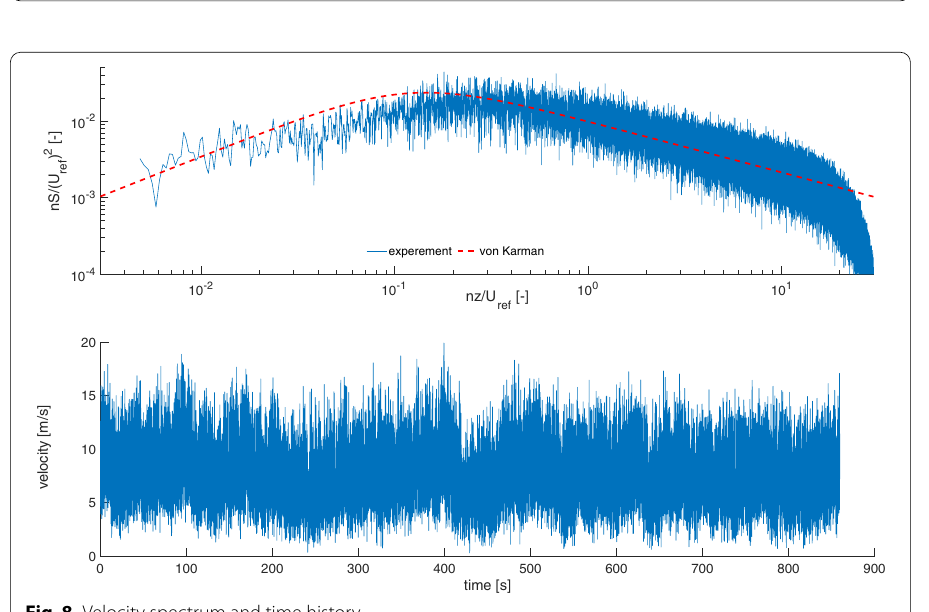
tunnels that have missing low-frequency fluctuations. However, Fig. 9 demonstrates that the turbulence content is not regulated merely by varying the velocities in the same test section, and at the same elevation and position in the test facility. The integral length scale of turbulence is governed by the scale of the model, size of the test section, and the location of model in the jet facility as well. The integral length scale is expected to be greater in size than the large-scale models being tested for accurate wind load predic- tions [24]. Velocities were recorded at mean velocities ~8 m/s (low-speed case) and ~11 m/s (high-speed case, referred as HS in Fig. 9) at location 1.5 H and 2 H, where H is the height of test section. It is noticed that the energy content in the low and high